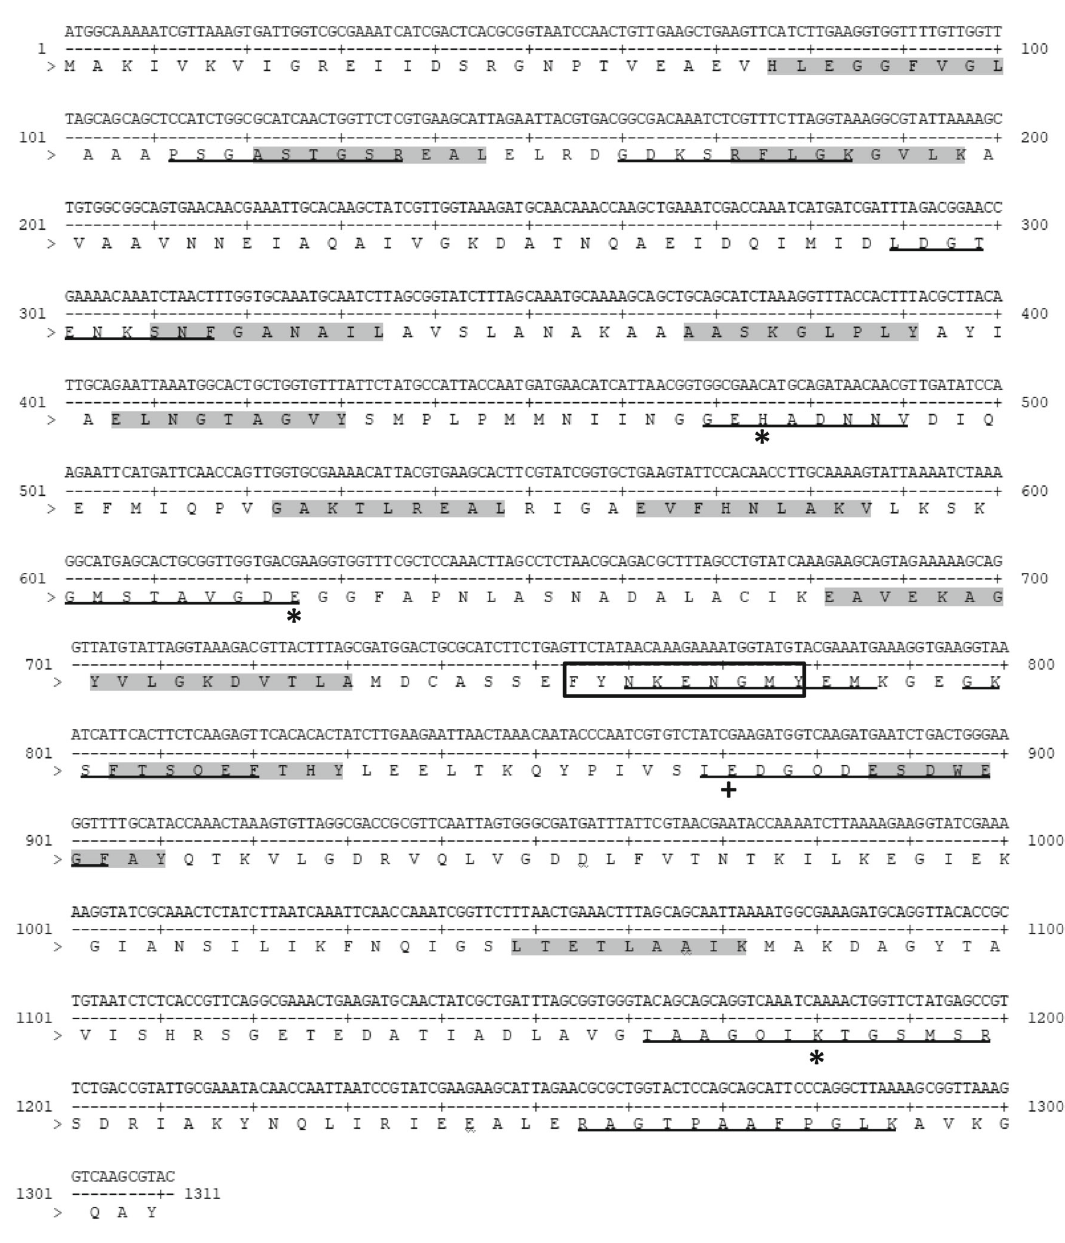
Figure 4: Predicted NTHiENO B and T cell epitopes. The coding region of NTHiENO gene and its translated protein sequence are shown; linear B cell epitopes are underlined; CTL epitopes are shadowed in gray. An asterisk indicates the amino acids involved in the catalytic site (H , E , and K ) and with a plus sign and the amino acid involved in binding to Mg 2+ 159 209 394